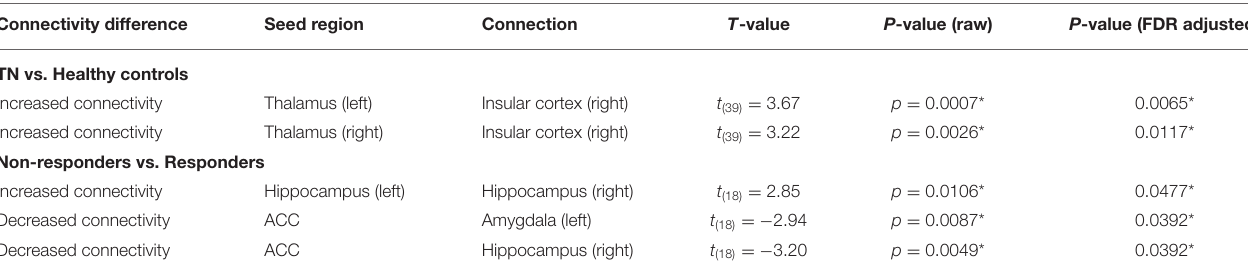
TABLE 3 | Functional connectivity differences between TN patients and healthy controls, and responders and non-responders to surgical treatment for TN. Connectivity difference